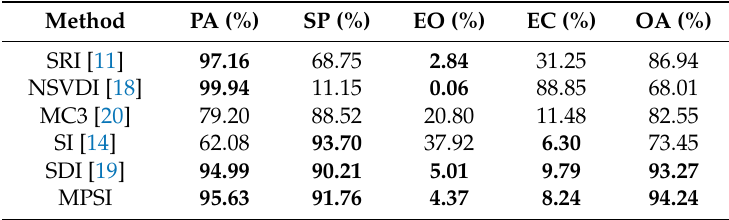
Table 2. Shadow detection accuracy data for test image B in Figure 6a.